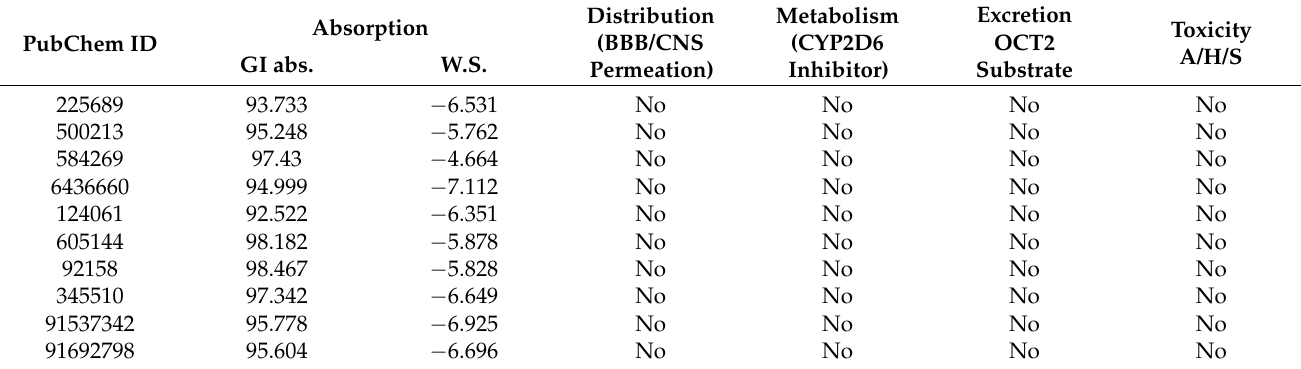
Table 6. ADMET properties of the top hit selected